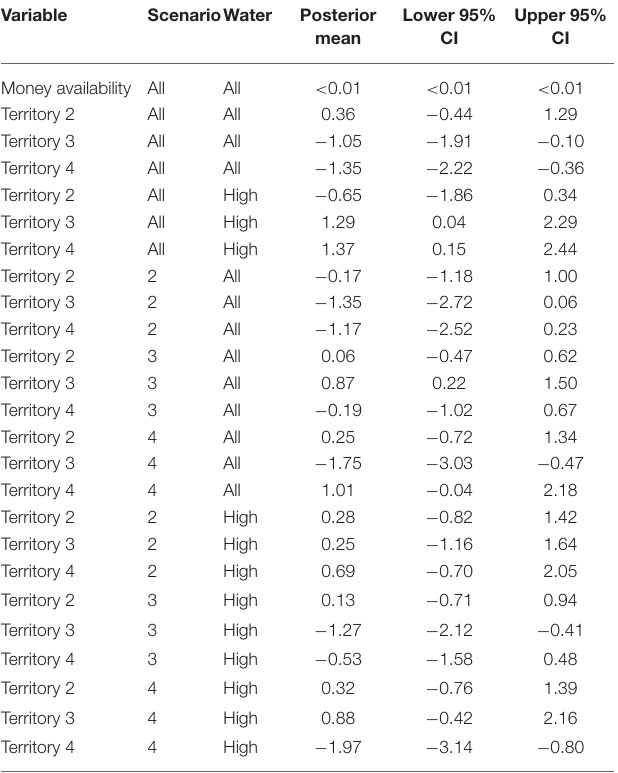
TABLE 3 | We report the posterior mean and the 95% credible interval for the territory selection model. Variable